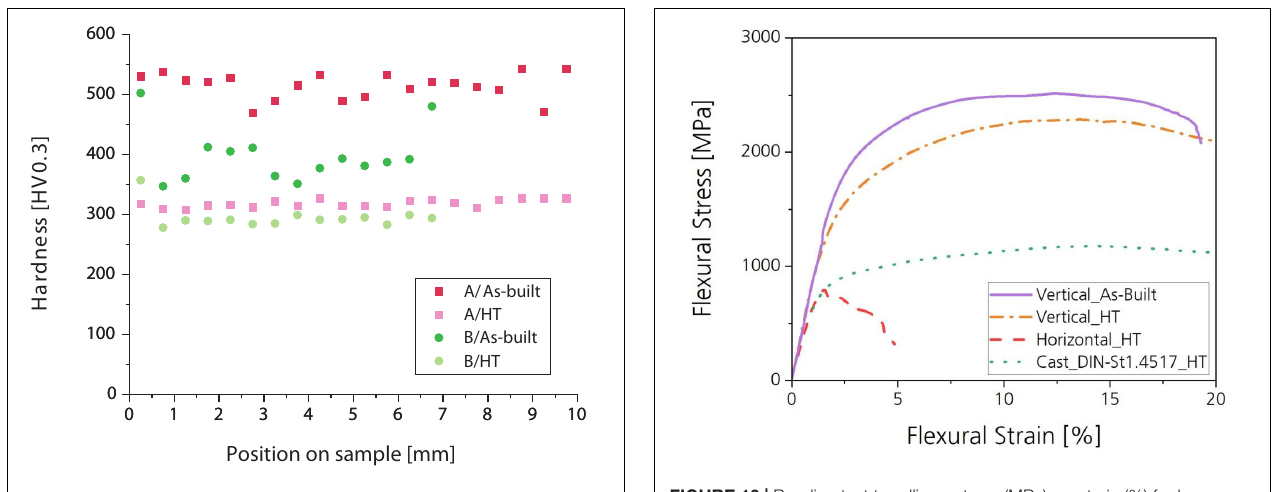
FIGURE 10 | Bending test trendlines–stress (MPa) vs. strain (%) for laser material deposition fabricated B samples in as-built and heat-treated condition in a vertical build orientation (Vertical_As-Built, Vertical_HT), heat treated in a horizontal build orientation (Horizontal_HT), and a reference heat-treated DIN St.1.4517 cast sample material